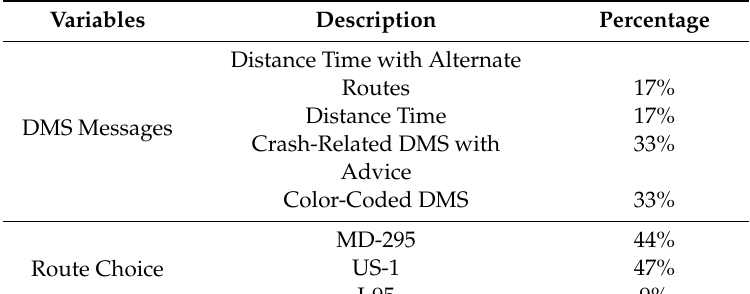
Table 5. Descriptive statistics of route choice dataset.